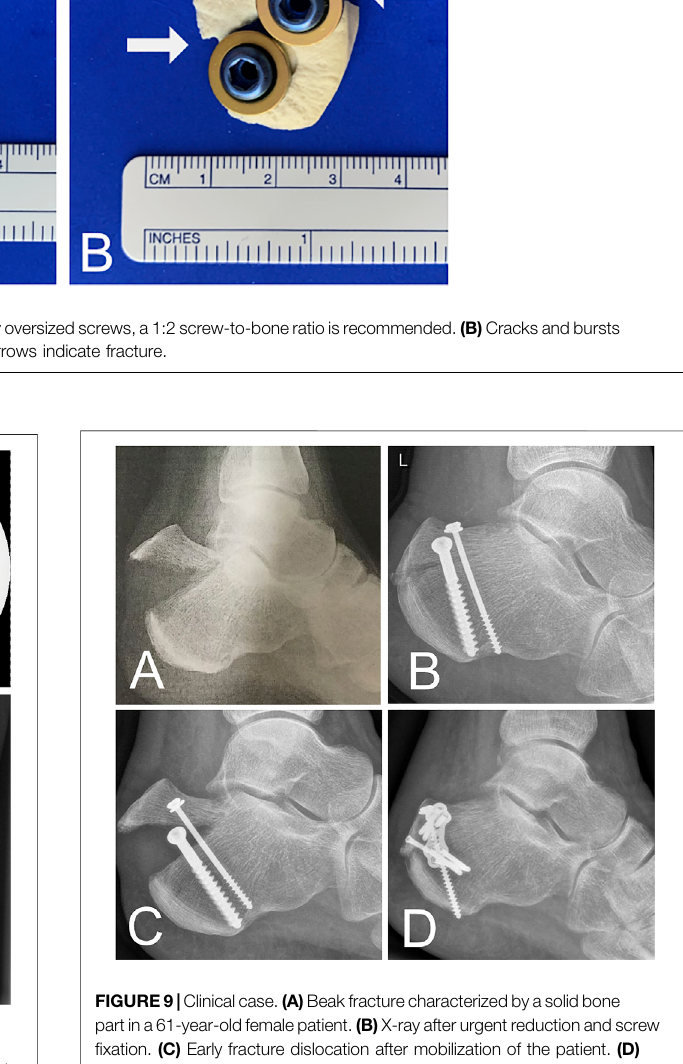
FIGURE 8 | Clinical case of a calcaneal avulsion fracture successfully treated using 5.0-mm headless cannulated compression screws. (A) Lateral x-ray showing a fracture gap caused by tension of the Achilles tendon. (B) Intraoperative fl uoroscopy demonstrating percutaneous reduction by a pointed reduction clamp. (C and D) Postoperative x-ray after 12 months demonstrating osseous healing in lateral and ap views.